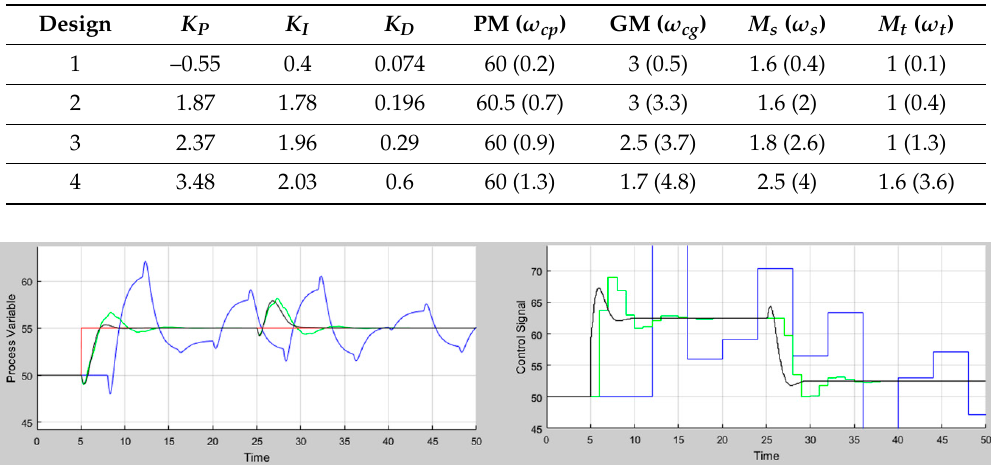
Figure 9. Responses with different controller sample times.